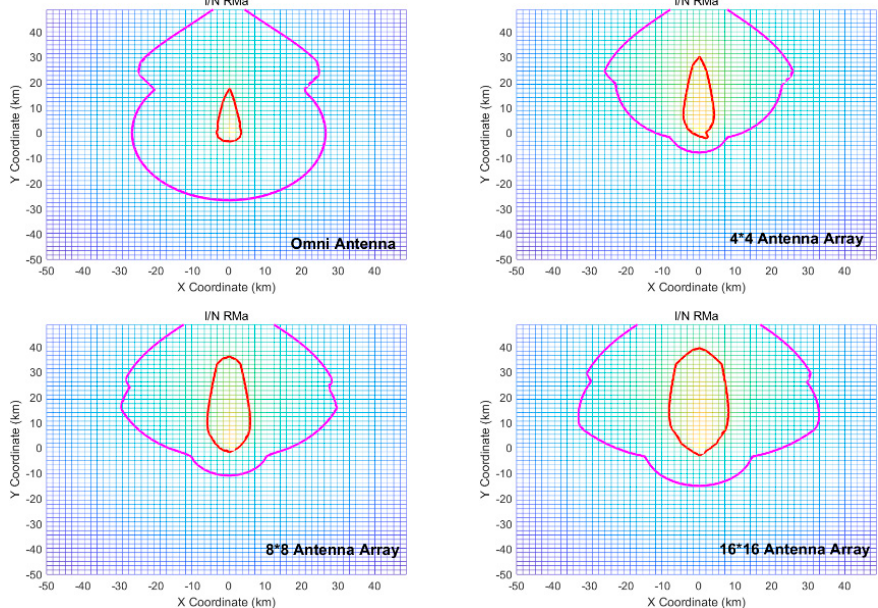
Figure 26. The size of exclusion and restriction zones for different RMa scenarios.